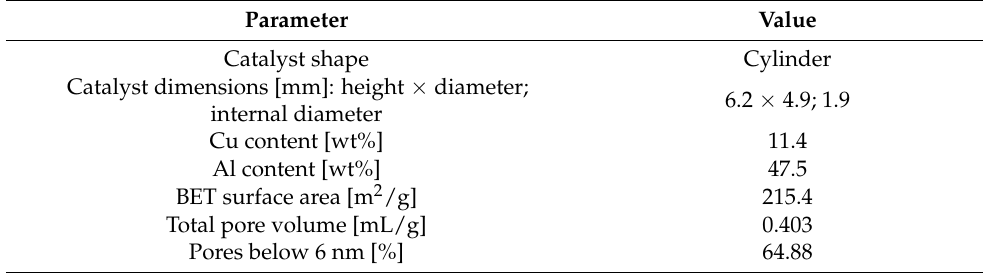
Table 4. Fresh Cu-based catalyst prepared with non-calcined support impregnated in a 20 wt% solution description, XRF analysis and BET analysis